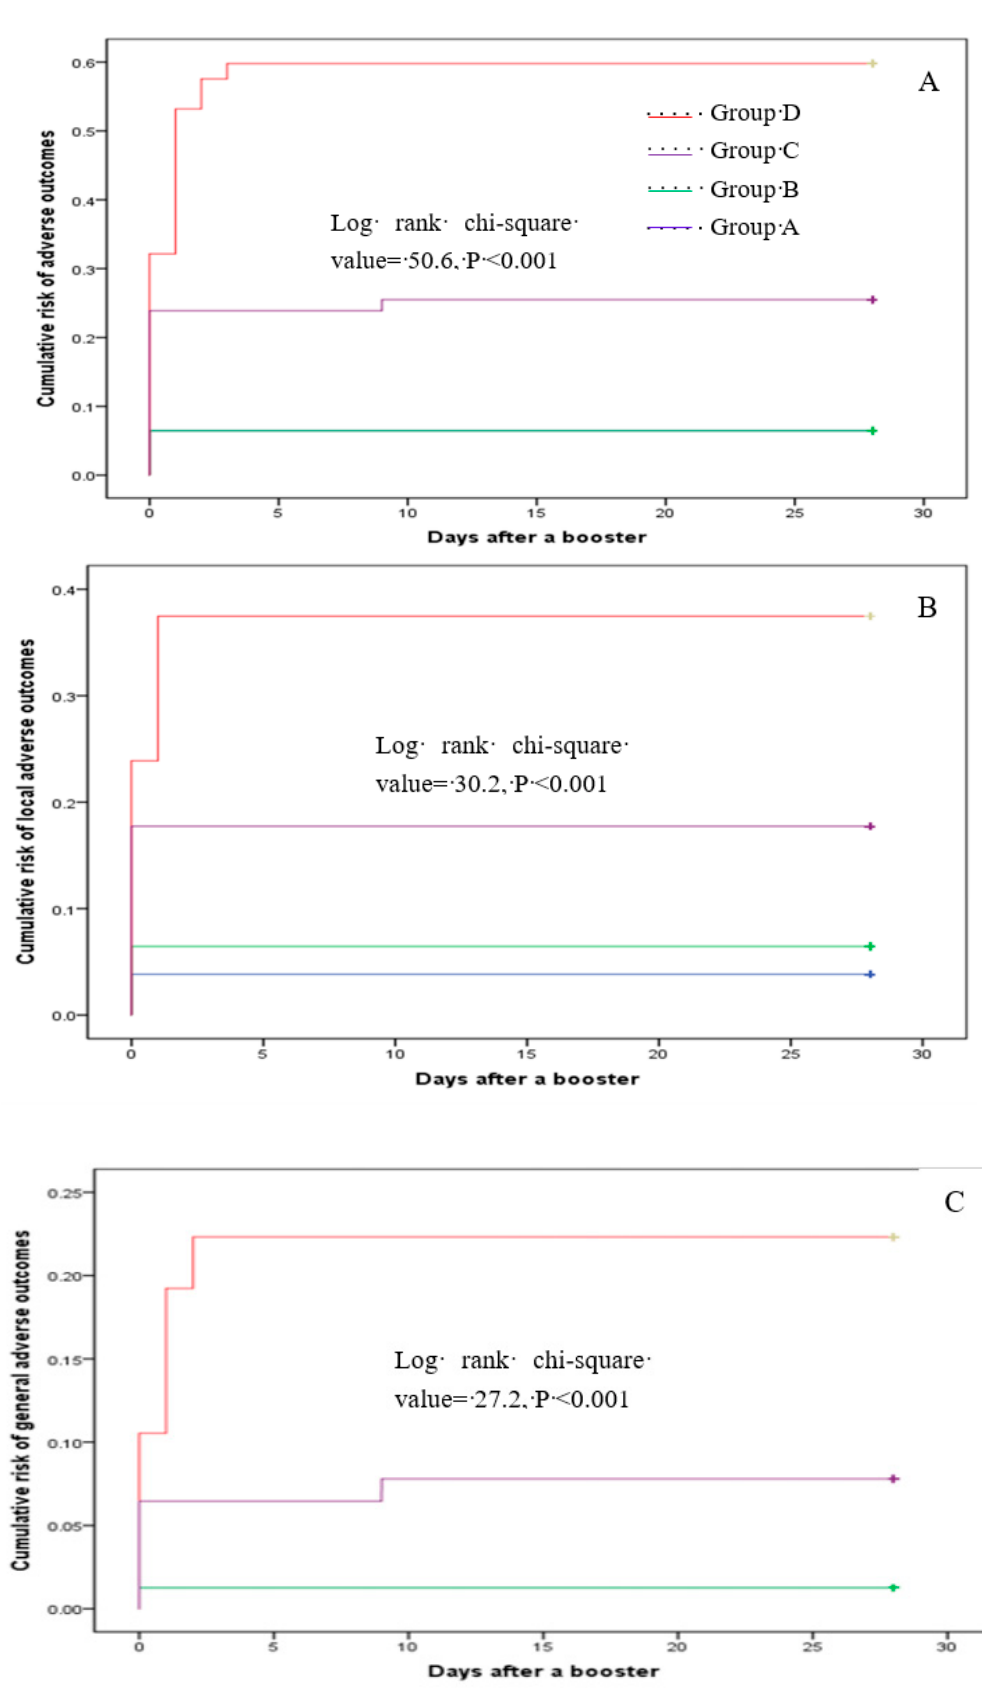
Figure 2. Cumulative risk of total ( A ), local ( B ), and systemic ( C ) reactions.